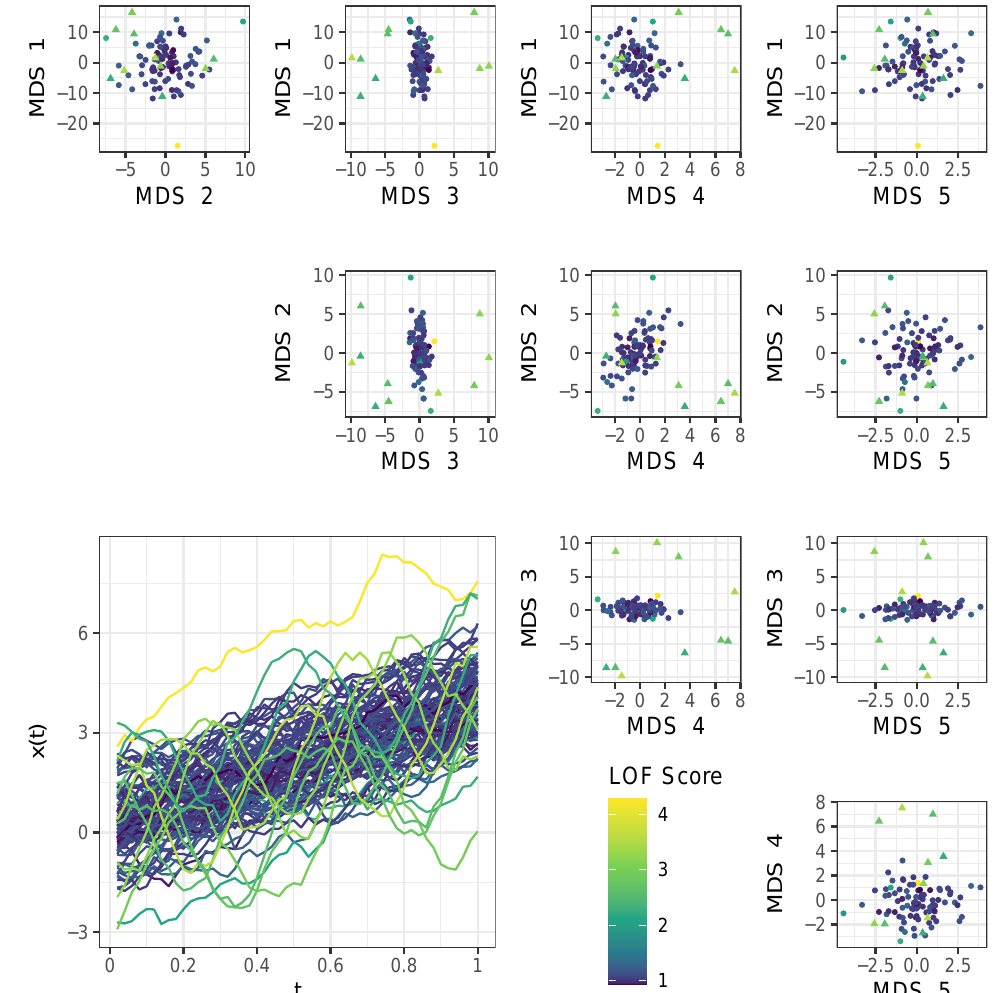
Figure A14. Model 7 data: scatterplot matrix of all 5 MDS embedding dimensions and curves; lighter colors for higher LOF score of 5D embeddings. True outliers depicted as triangles. Note that the true outliers are clearly separated from the rest of the data in embedding subspace 3 vs.